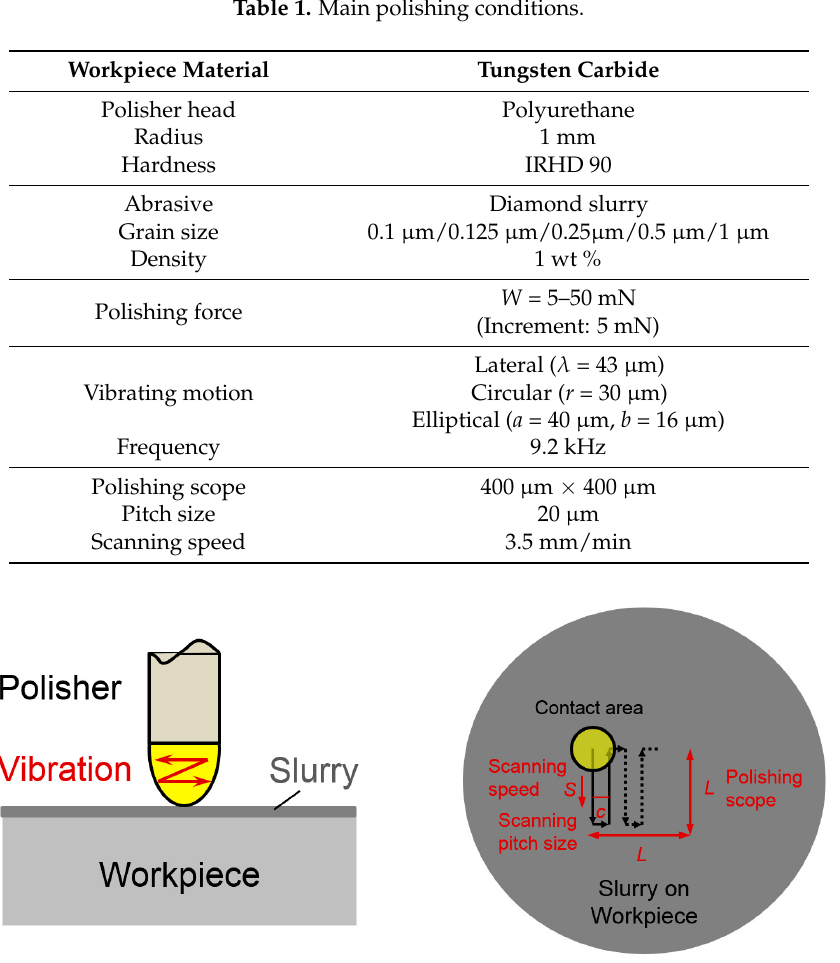
Table 1. Main polishing conditions.